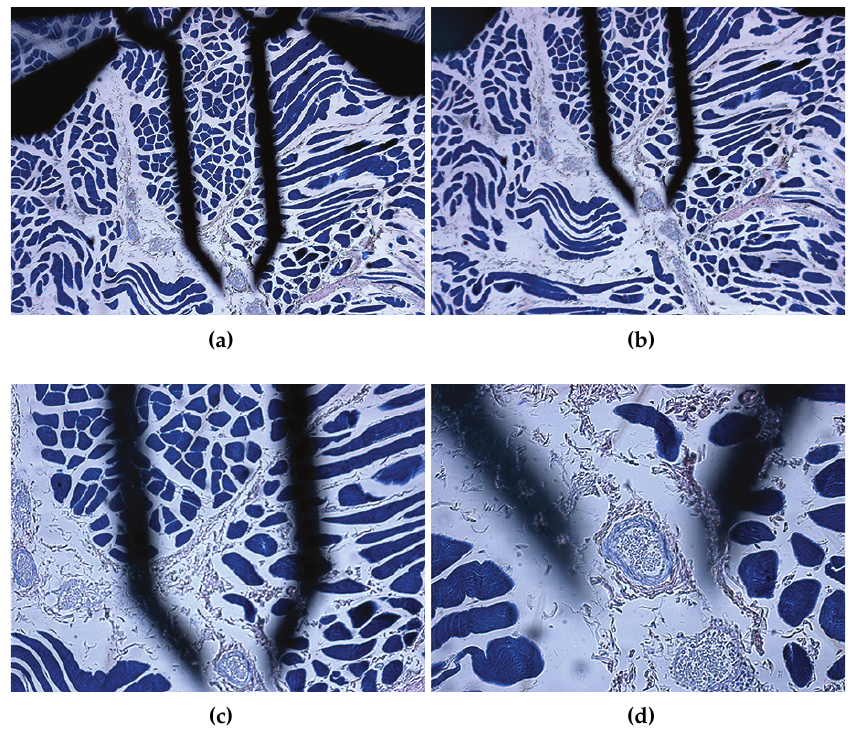
Figure 15. Heart and gripper with different focus distances. ( a ) Heart (Focus a); ( b ) Heart (Focus b);